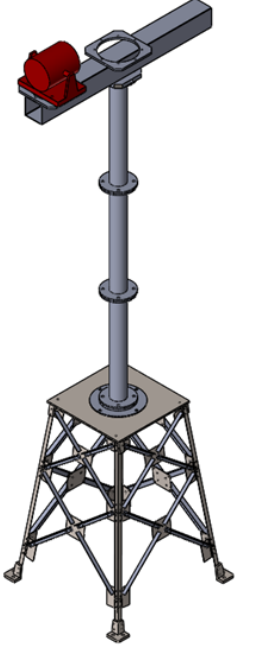
Figure 2. 3D model of the lab-scale offshore wind turbine jacket